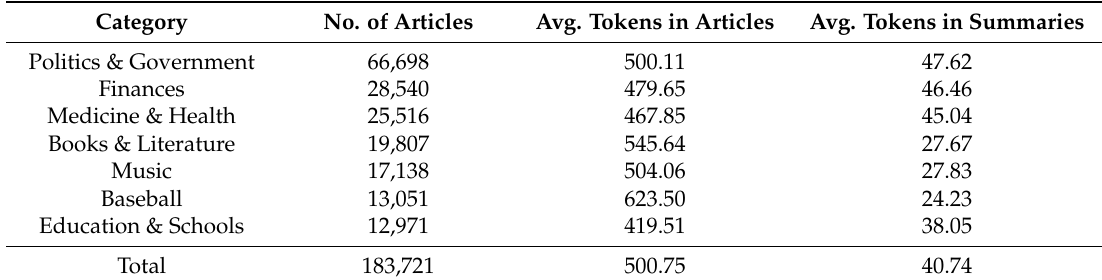
Table 2. Simple statistics on the New York Times (NYT) Corpus.